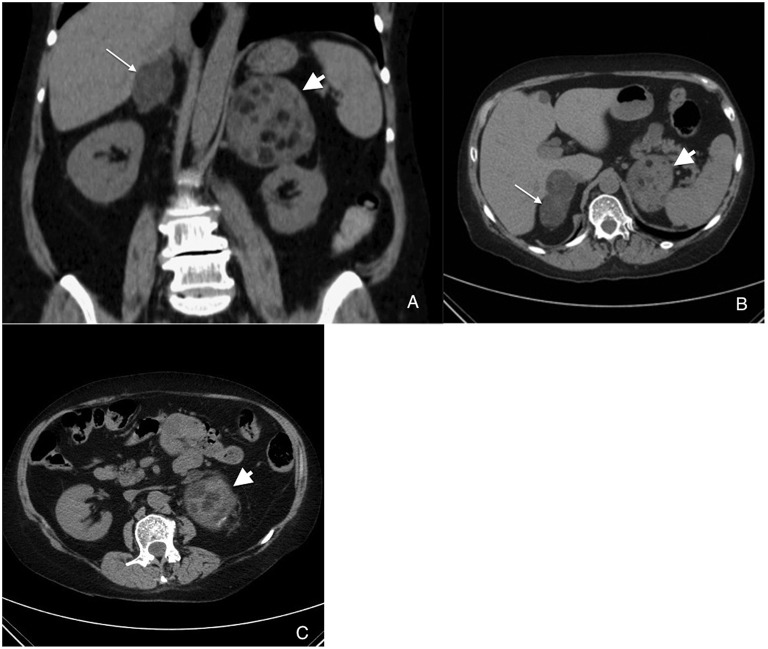
Coronal (A) and axial (B,C) views of adrenal CT scan showing bilateral adrenal enlargement with features of mixed BMAH (right; thin arrow) and myelolipoma (particularly on left; short arrow).